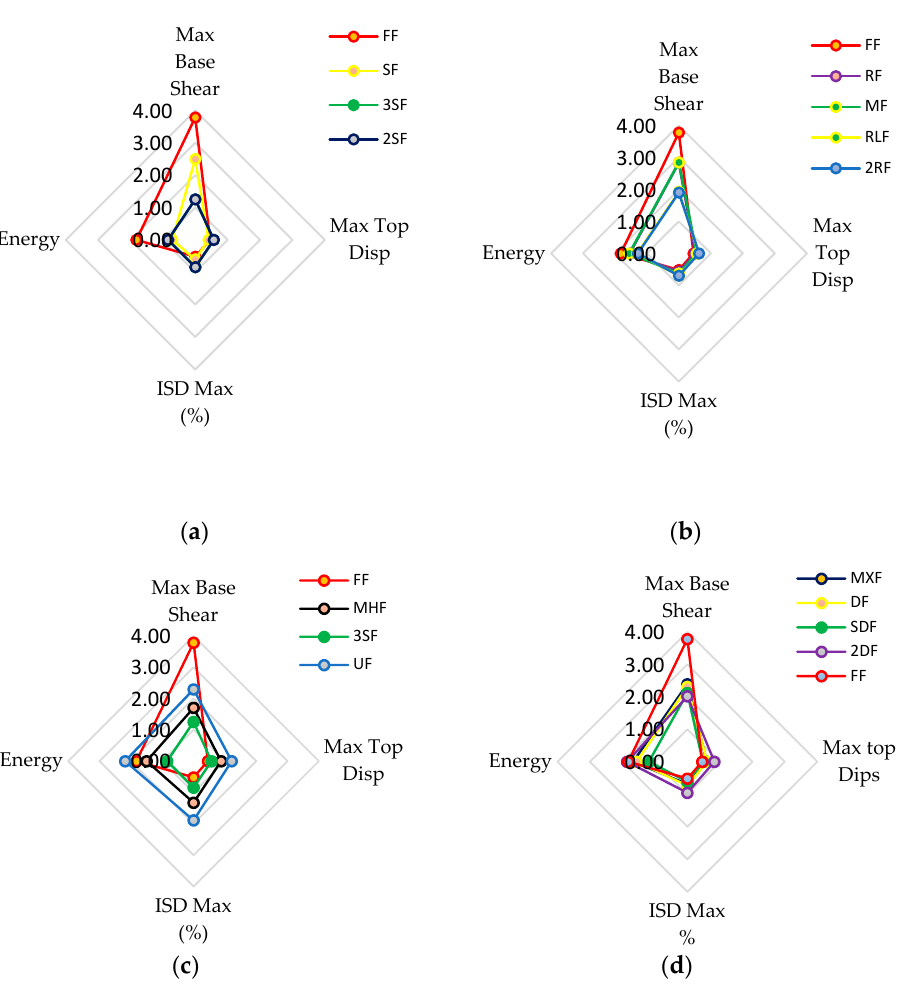
Figure 12. Radar diagrams to compare the studied results in the four cases. ( a ) Study Case N°:1, ( b ) Study Case N°:2, ( c ) Study Case N°:3, ( d ) Study Case N°:4.